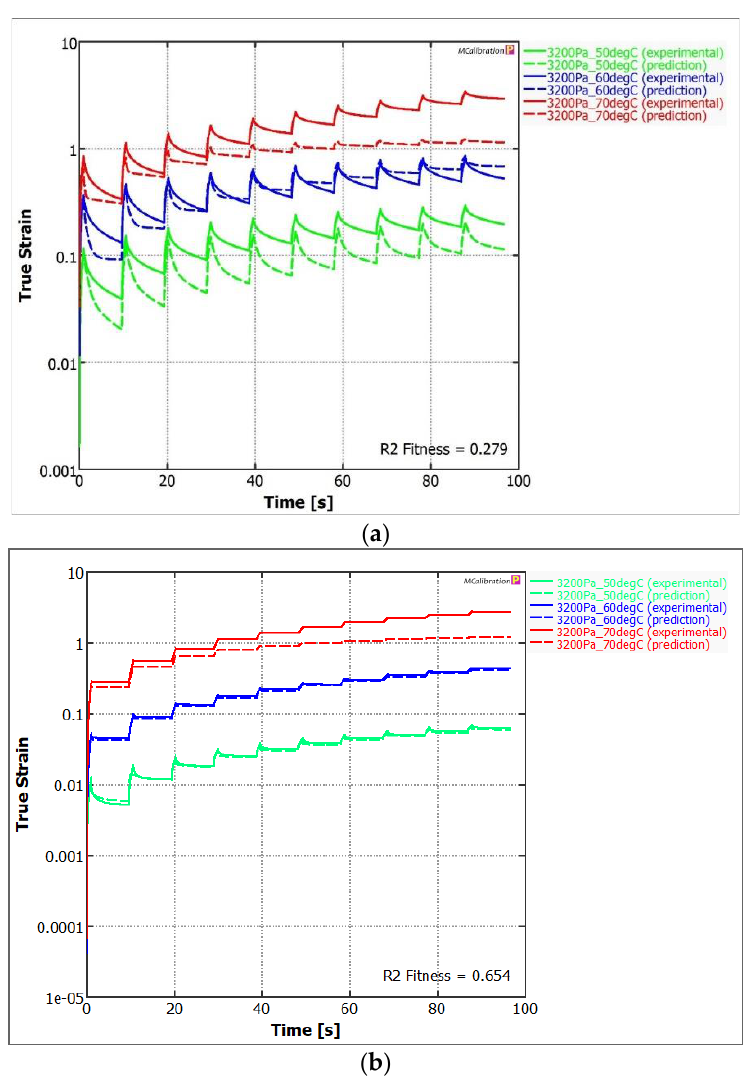
Figure 12. Comparison of the match between the generalised Maxwell model and the experimental results of cyclic strain at 100 Pa and 3200 Pa acc. to the MSCR [55]: ( a ) PmB 45/80-55; ( b ) case 8 s.